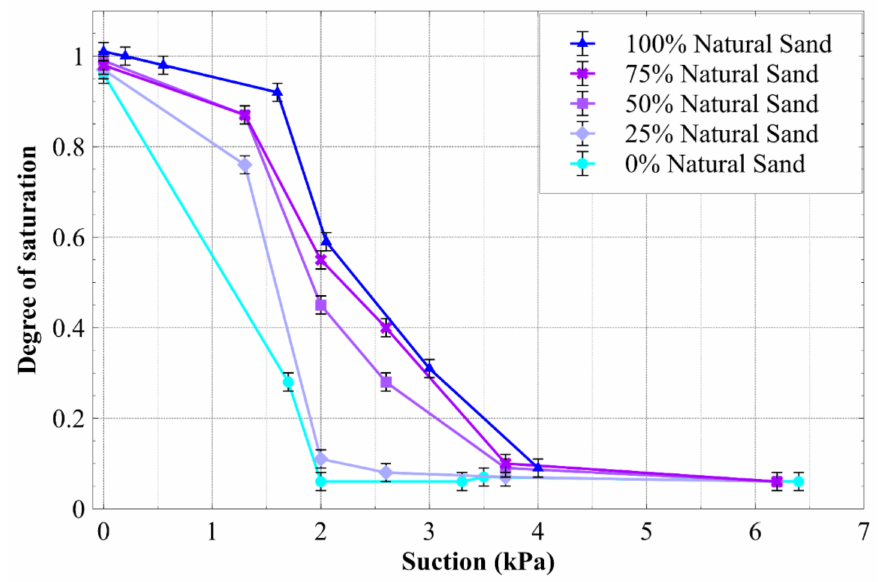
Figure 6. Drying path of the water retention curves of different sand mixtures, expressed as the saturation degree vs.